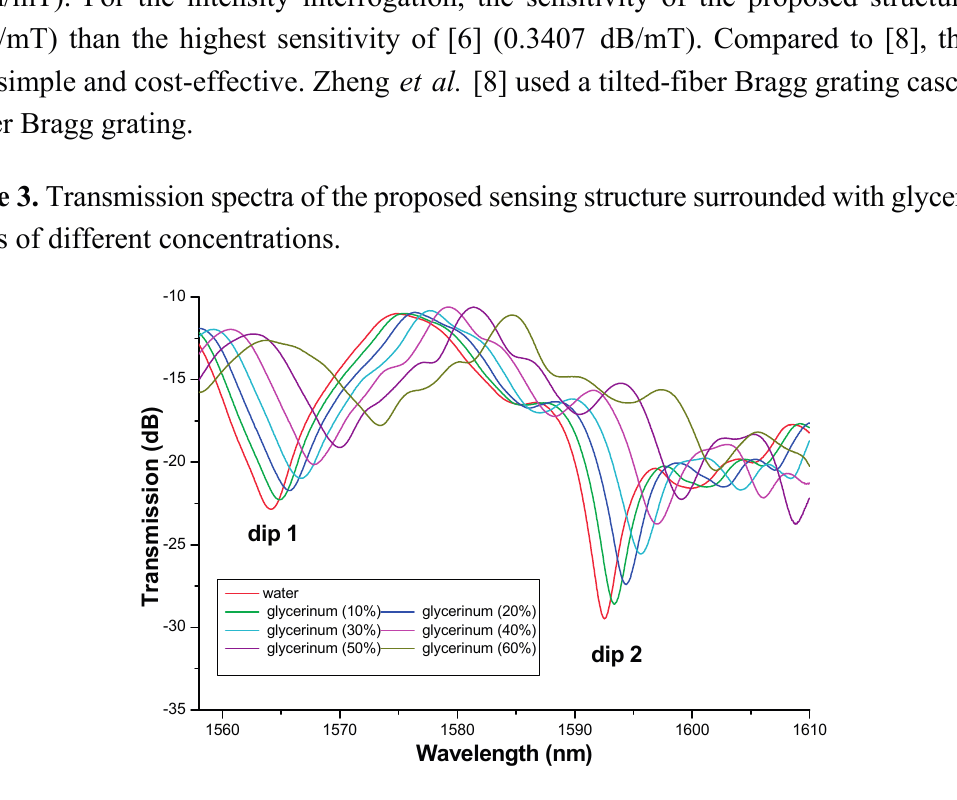
Figure 4. Transmission spectra of the proposed sensing structure at magnetic field strength ranging from 0 to16